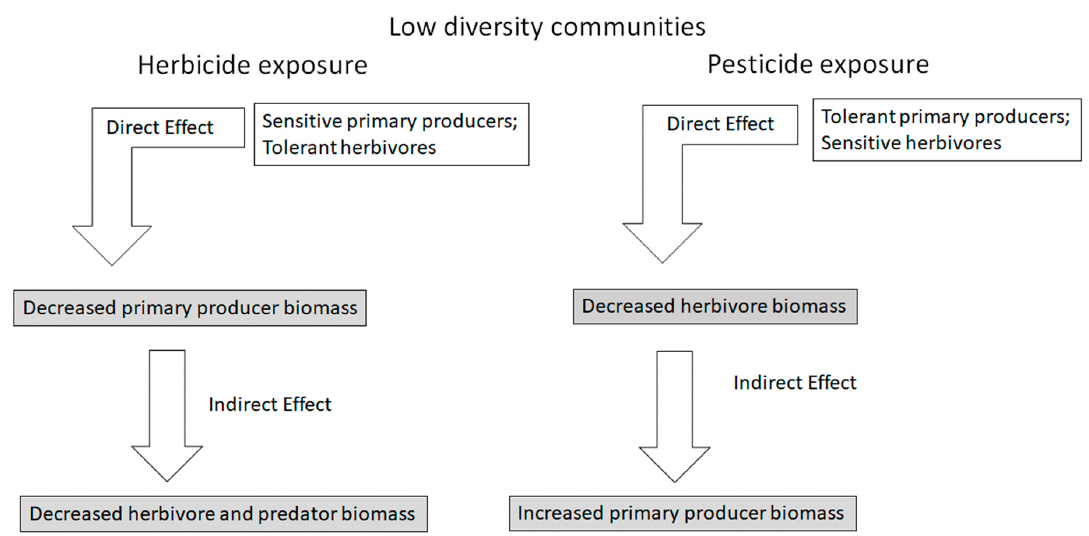
Figure 2. Hypothetical indirect effects of separate exposures of a pesticide and an herbicide in a low-diversity ecosystem. In each case, exposure will lead to strong and relatively predictable indirect effects with straightforward causative mechanisms. Ecosystem state changes caused by direct and indirect effects are described in shaded boxes.